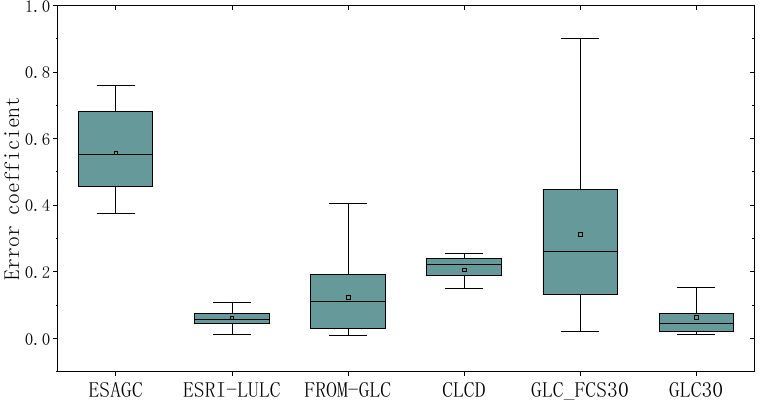
Figure 8. Scatter plots showing a comparison of the cropland area at the county level in Guangxi between the six land cover data sets and the statistical yearbook data.